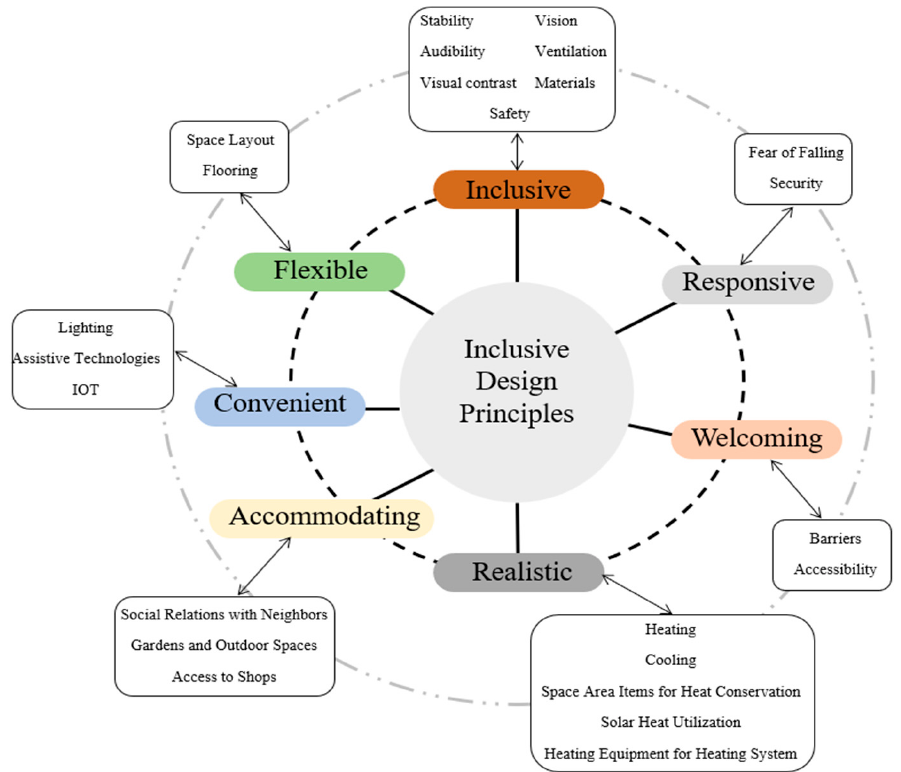
Figure 8. A proposed conceptual framework of integrated, inclusive design principles in interior design for elderly houses, as stated by Mnea and Zairul (2023), [71]. Inclusive , everyone can use safely, easily and with dignity; Responsive, taking account of what people say they need and want; Flexible , different people can use spaces, layout in different ways; Accommodating , for all people, regardless of their age, gender, mobility, ethnicity or circumstances; Convenient , everyone can use without too much effort or separation; Welcoming, no disabling barriers that might exclude some people; Realistic , offering more than one solution to help balance everyone’s needs and recognizing that one solution may not work for all.